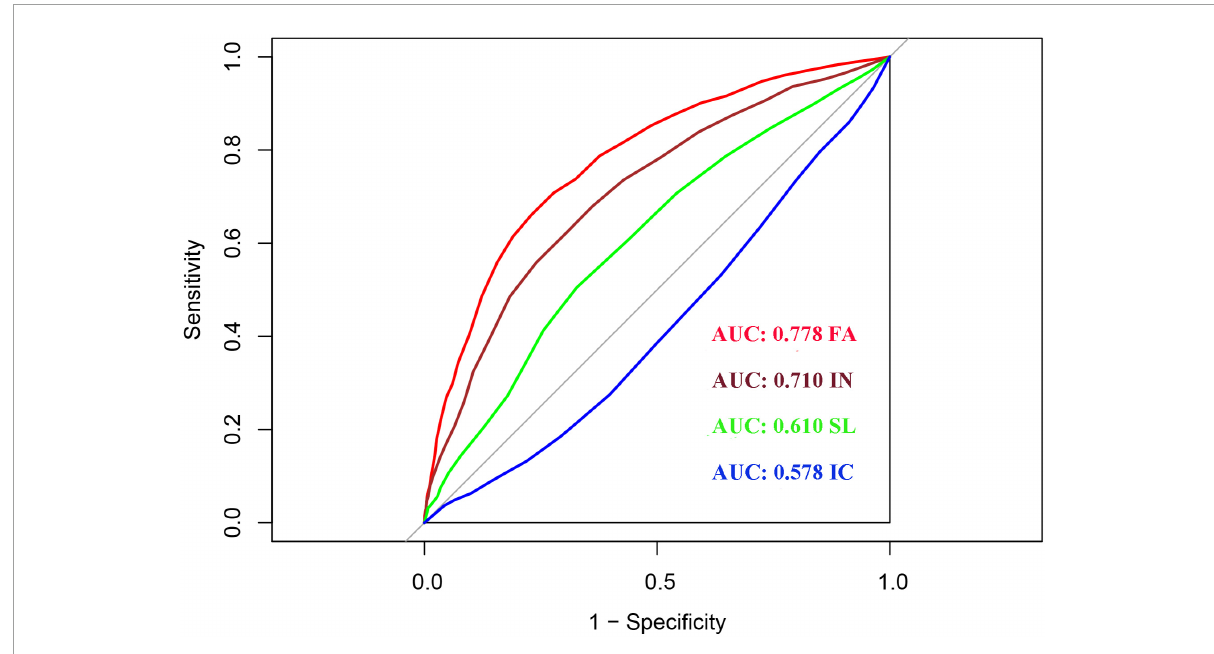
FIGURE2 Receiver operating characteristic (ROC) analysis of each dimension of Self-Rating Scale of Systemic Family Dynamics (SSFD).